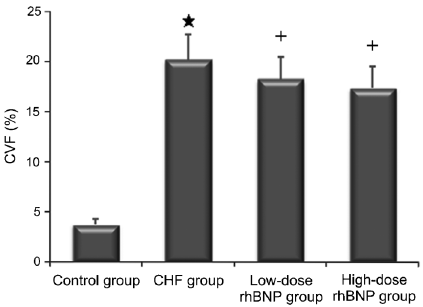
Figure 3. Collagen volume fraction (CVF) values of rats in different groups. Data are reported as means±SD. CHF: chronic heart